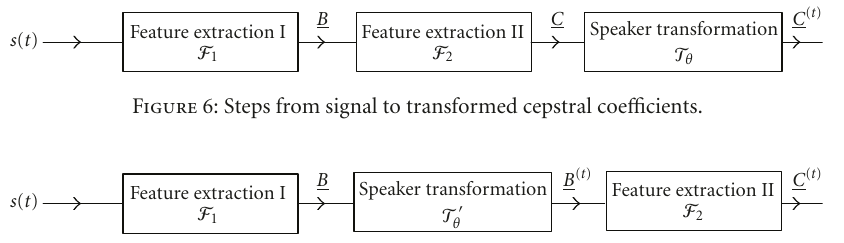
Figure 7: Steps from signal to transformed cepstral coe ffi cients when transformation is applied in a signal-equivalent